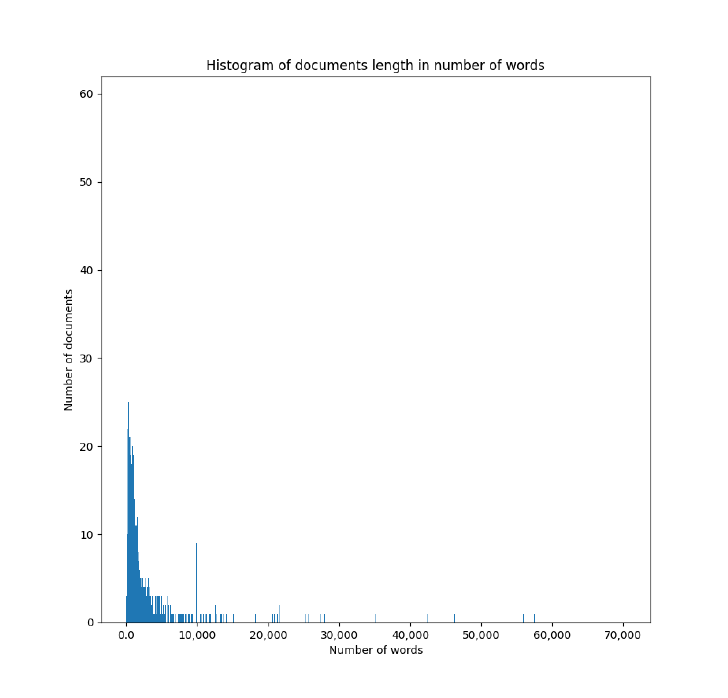
Figure 15. Distribution of words frequency in